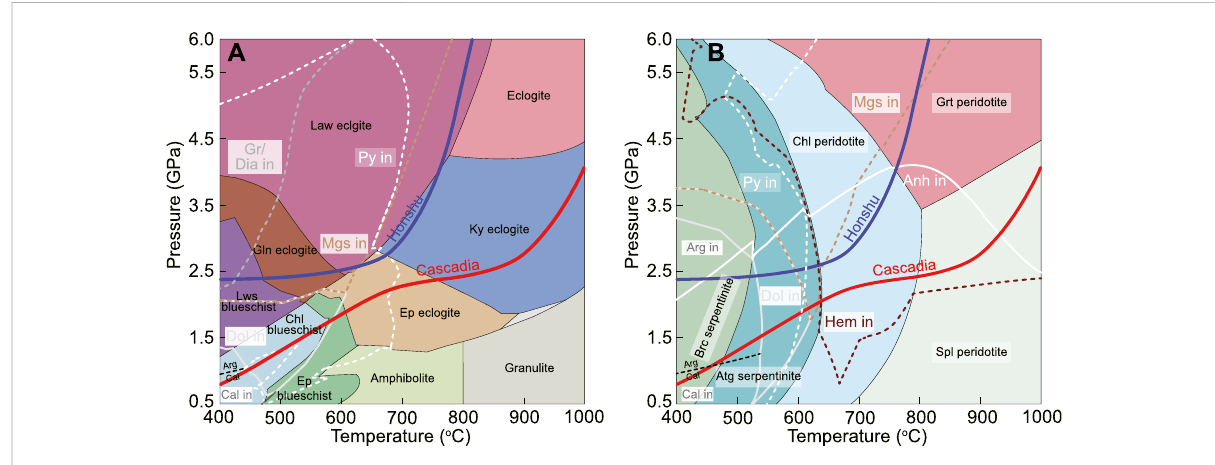
FIGURE 1 Diagrams showing the division of common rock types and the stability P – T fi elds of carboniferous and sulfurous minerals in the AOC (A) and serpentinite (B) systems, based on Supplementary Figure S2. Top-of-slab subduction geotherms for Honshu (cold) and Cascadia (hot) endmember models are after Syracuse et al. (2010). Mineral abbreviations (Whitney and Evans, 2010) used in this study can be found in Supplementary Table S2.